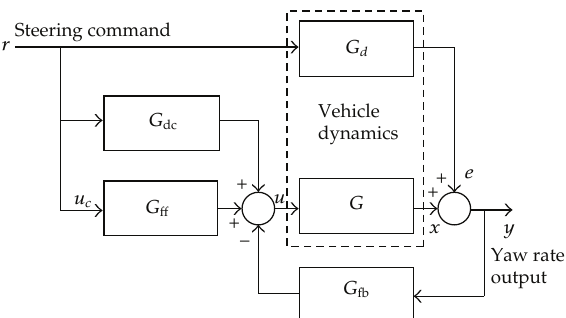
Figure 11: Block diagram representing the original yaw-rate control